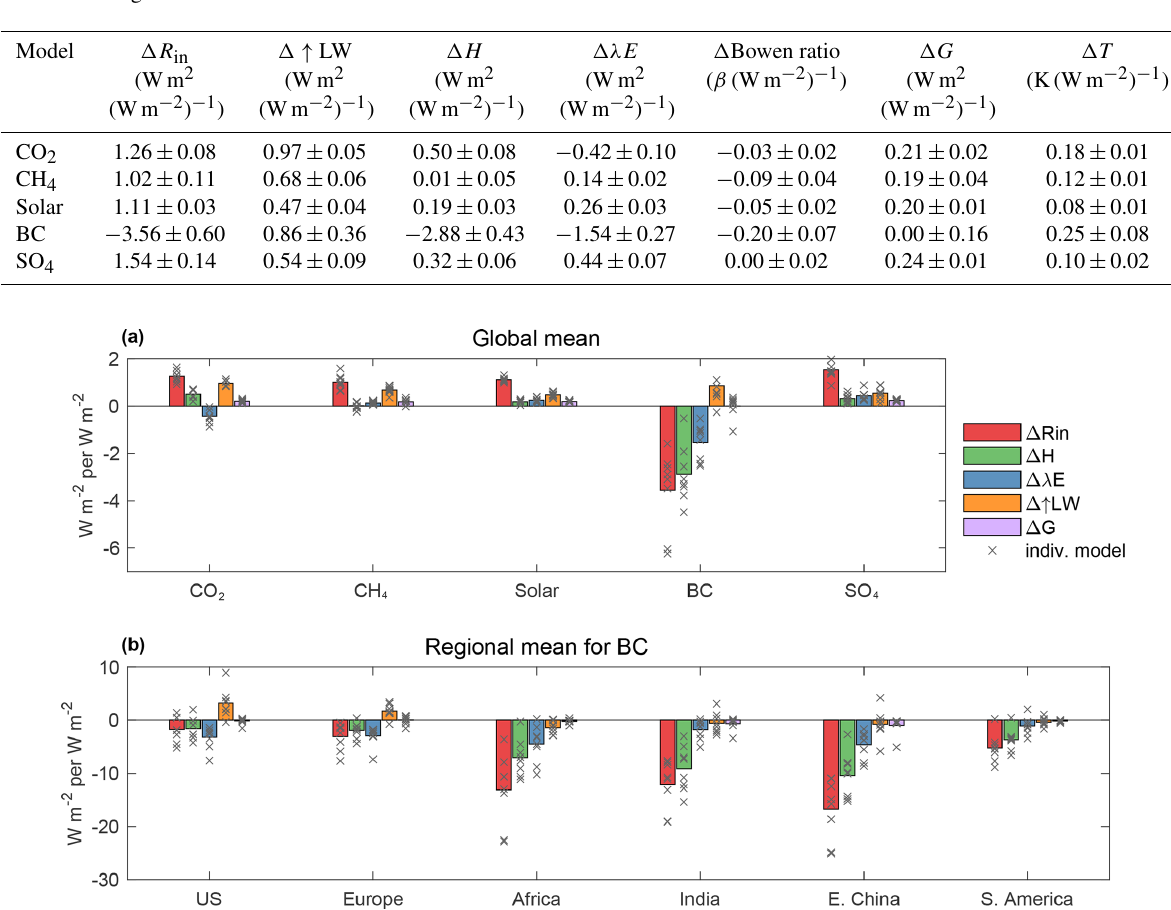
Figure 4. Domain-averaged values of R in and the components of E out from the fsst simulations for global mean (a) and for selected regions under BC forcing (b) . × indicates the values from individual